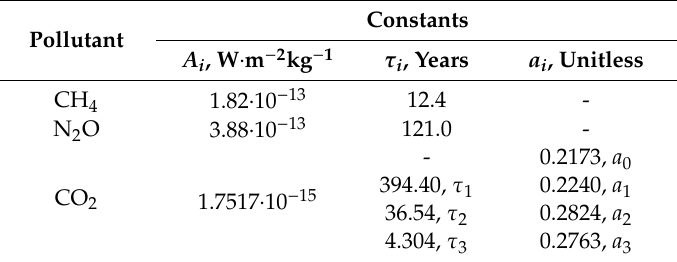
Table 2. Specific radiative forcing ( A i ), perturbation lifetimes ( τ i ), and parameter a i values for the calculation of the pollutant’s fraction remaining in the atmosphere ( R i )